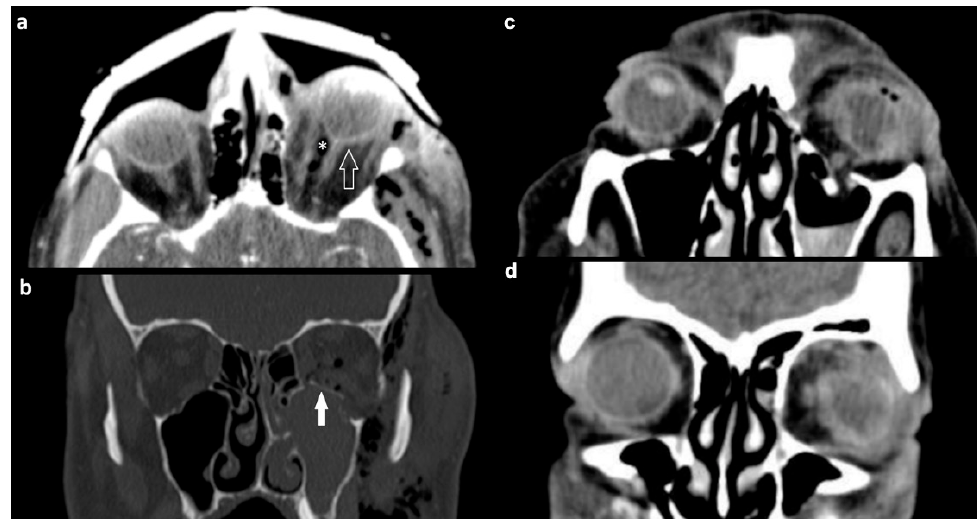
Figure 3. ( a , b ) Orbital compartment syndrome after blow-in fracture of the left orbital floor. NE-MSCT ( a ) Soft tissue window, axial reformation. Mass effect of a dislocated orbital floor fragment leading to left-sided exophthalmos with elongation of the optic nerve and deformation of the ocular bulb (globe tenting, indicated by hollow arrow). The posterior globe angle is reduced to 117° in the left globe, compared to 139° on the right side. Asterisk indicates intraconal air bubbles. ( b ) Bone kernel, coronal reformation. Solid arrow indicates the orbital floor fragment which is dislocated upwards into the orbital cavity. ( c , d ) Complete rupture of the left globe with irregular shape, volume loss, and air bubbles in the anterior chamber. NE-MSCT, soft tissue window in ( a ) Axial and ( b ) coronal reformation (NE-MSCT = non-contrast-enhanced multi-slice CT).